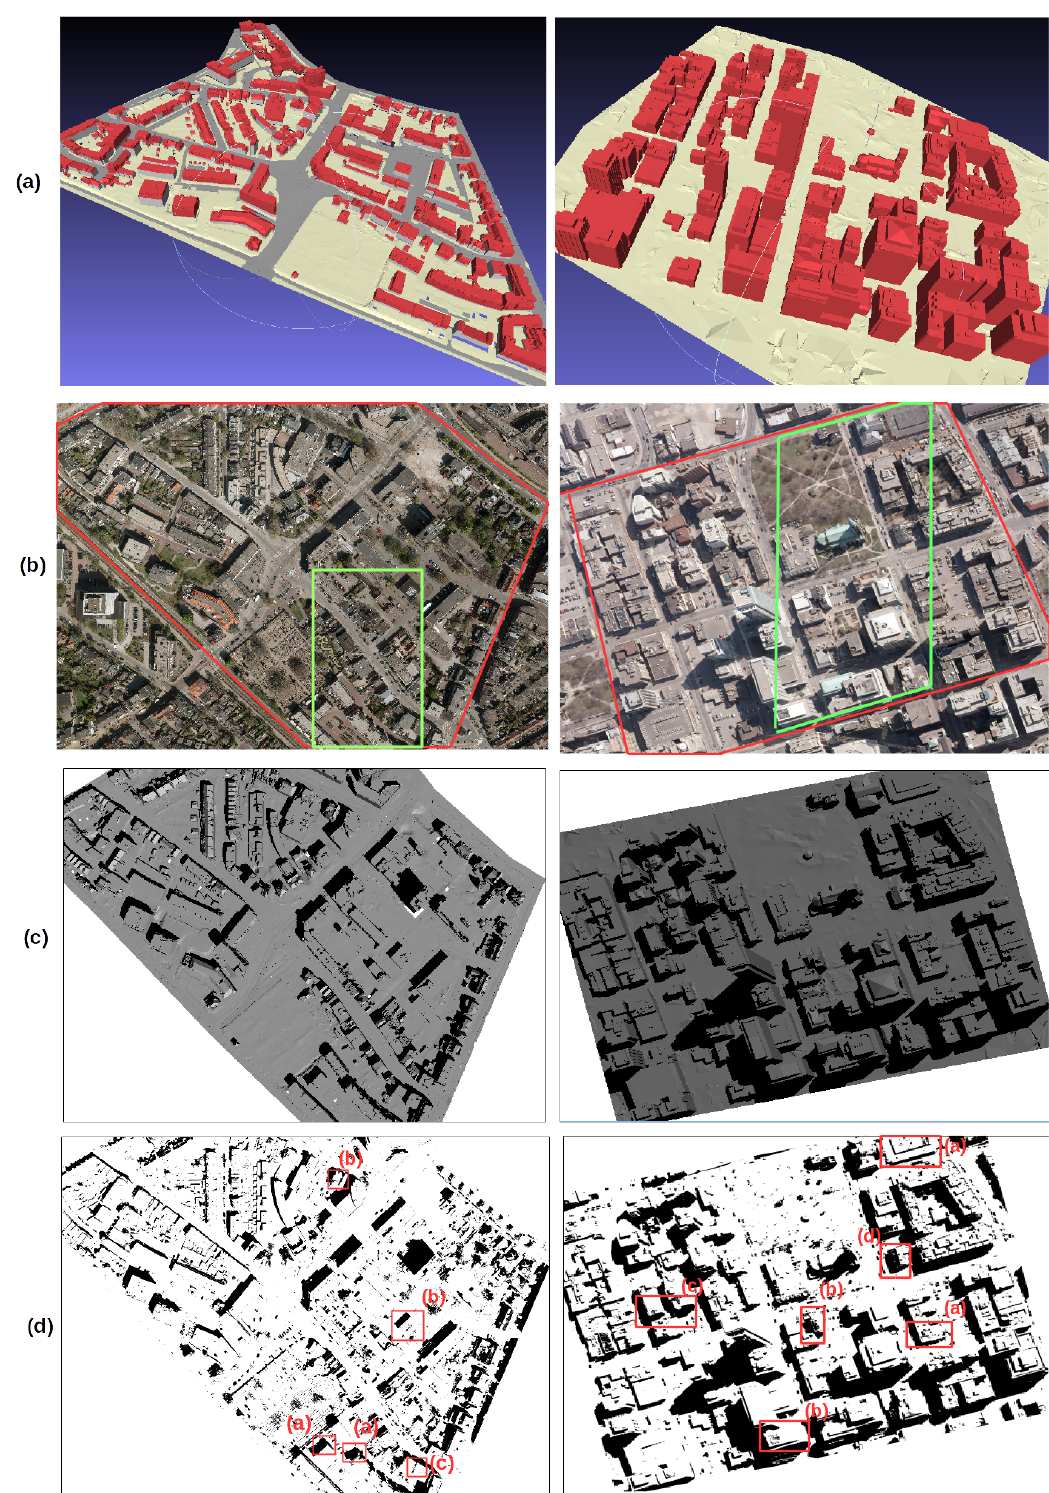
Figure 2. ( a ) The 3D city model for Amersfoort and Toronto. ( b ) The VHR images corresponding to the 3D city models. The area of interest is in the red box of two images. The green boxes indicate the area for creating test dataset manually. ( c ) The reconstructed shadow images from 3D models by ray tracing. ( d ) The shadow detected from VHR images by RF with free-training samples. The red boxes indicate the examples used in Section 4.2 to compare the results from four classification